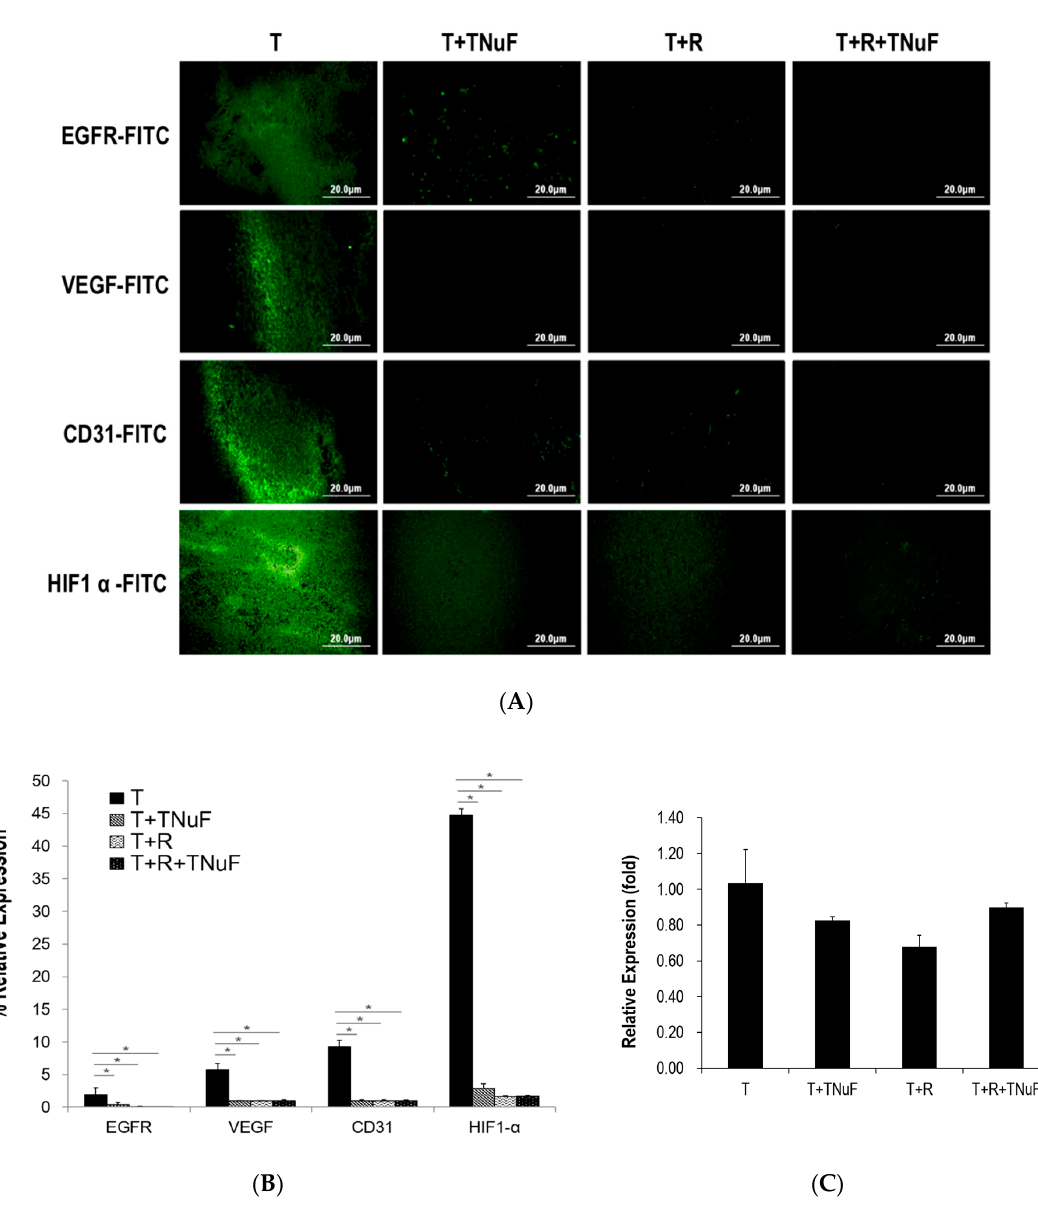
Figure 4. Expression of neoplastic processes and angiogenesis proteins in tumor tissues of tumor bearing mice treated with TNuF and/or plus irradiation. ( A ) Immunofluorescence analysis for tumor tissues treated with TNuF and/or plus irradiation. Images are shown at ×200 magnification. ( B ) Protein expression levels that are quantified and expressed as a relative change to the LLC cell-inoculated group. Asterisk (*) indicates a significant difference ( p value < 0.05) when compared to the control group. ( C ) Quantification of mRNA levels of vascular endothelial growth factor (VEGF) by qRT–PCR in the tumor tissues of all mice treated with TNuF, irradiation, and the combination of TNuF and irradiation.